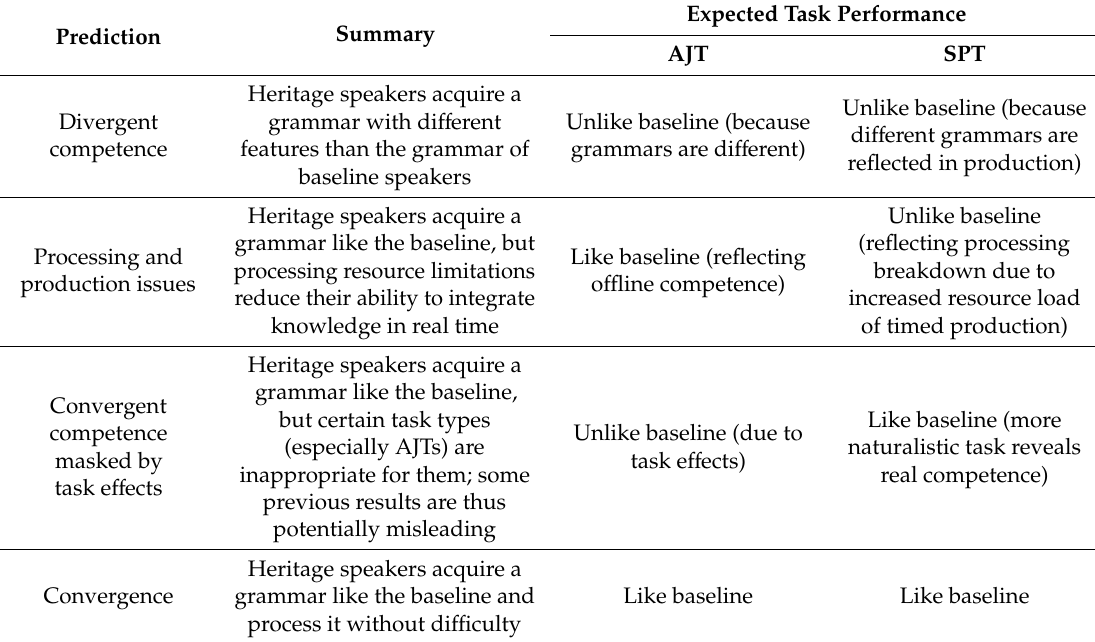
Table 1. Summary of